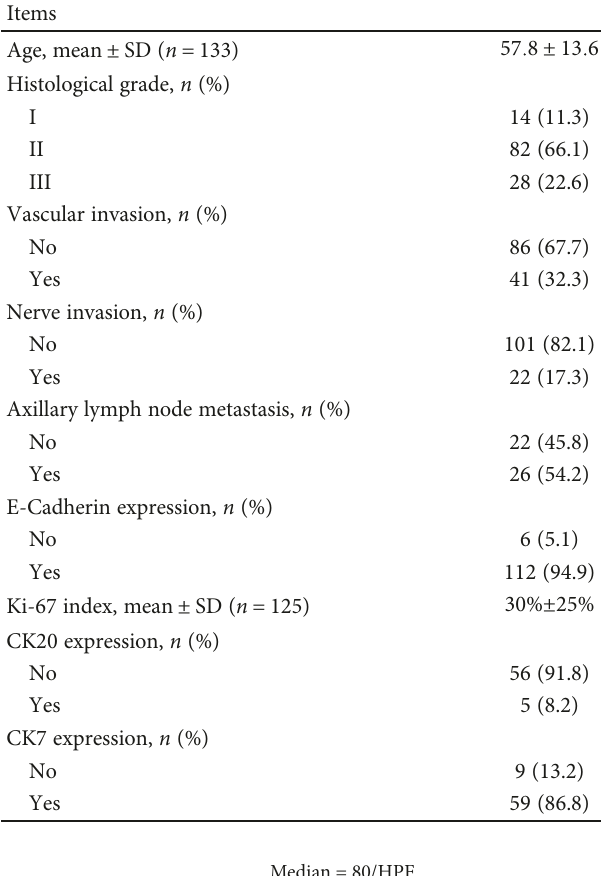
Table 1: The characteristics of patients.